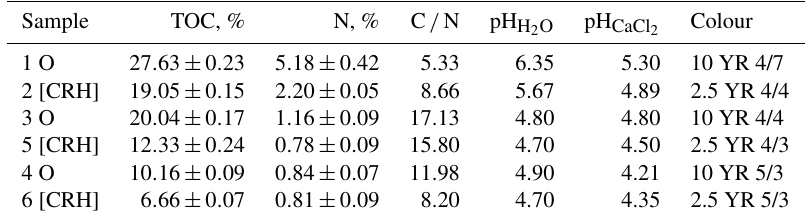
Table 1. Basic characteristics of soils. [CRH] represents buried humic cryogenic horizon. Sample TOC, % N, % C / N pH H